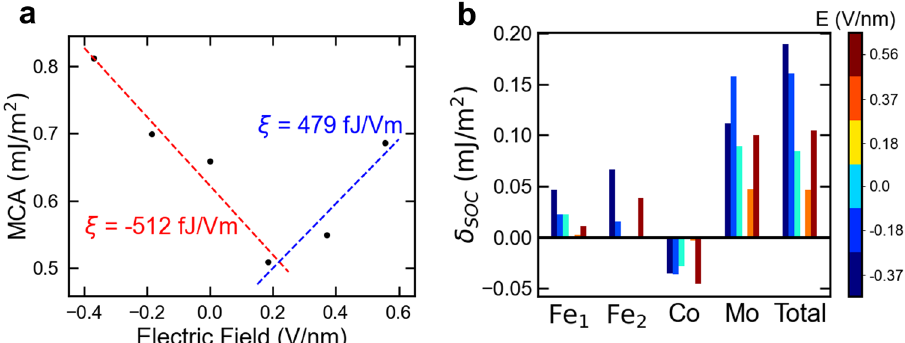
Fig. 5 Ab initio electronic structure calculations of anisotropy and VCMA. a Magnetic anisotropy as a function of electric fi eld in MgO for the Mo/FeCo/ MgO junction. b The E- fi eld-induced change of SOC energy difference ( δ SOC ) for the Mo/FeCo/MgO junction. The atom-resolved δ SOC is also shown.